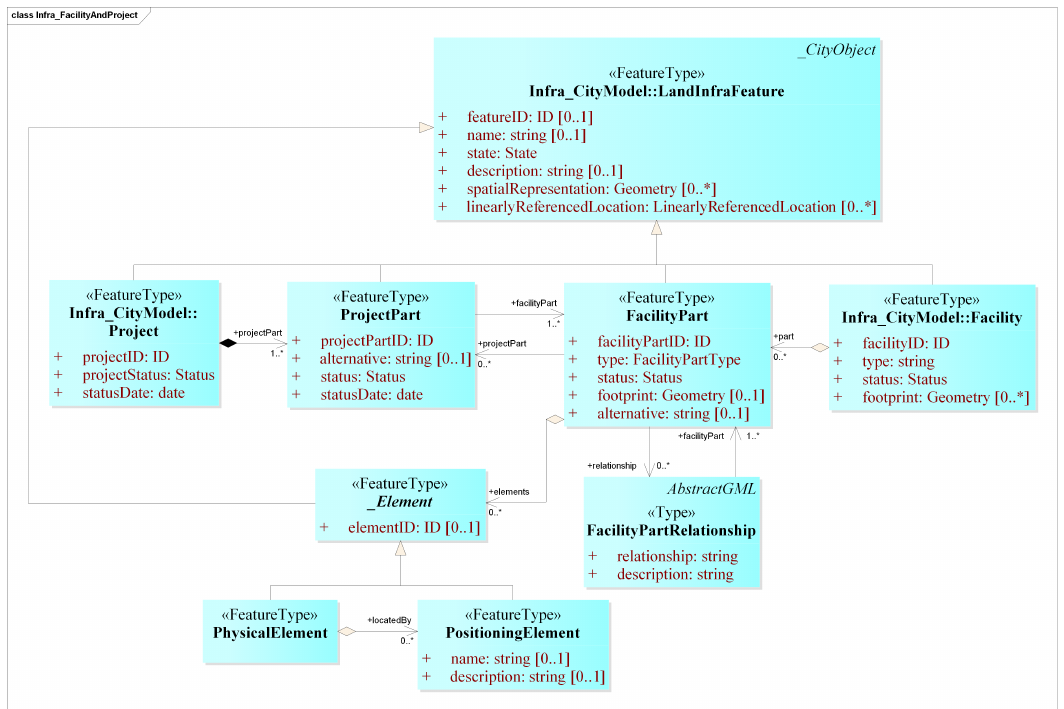
Figure A6. The UML excerpt depicts new LandInfra features Facility , and Project ) introduced in the CityGML Infra ADE.